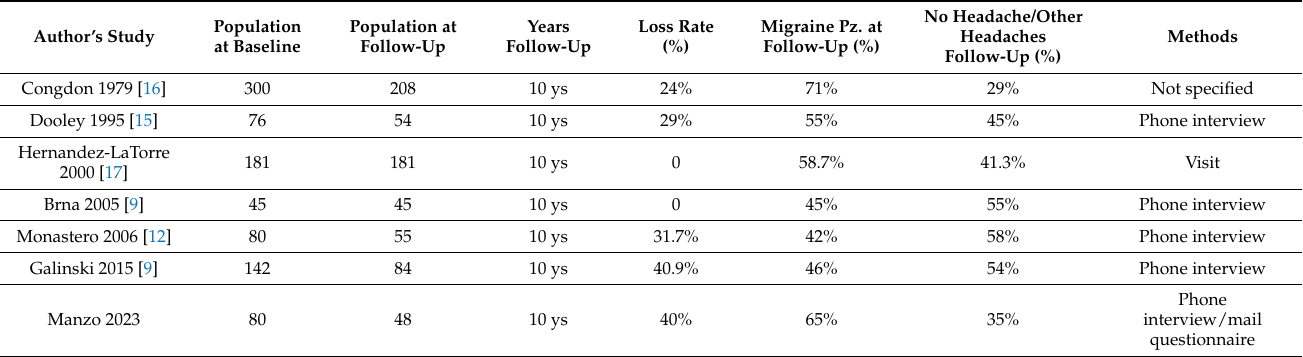
Table 5. Main 10-year follow-up studies compared to our